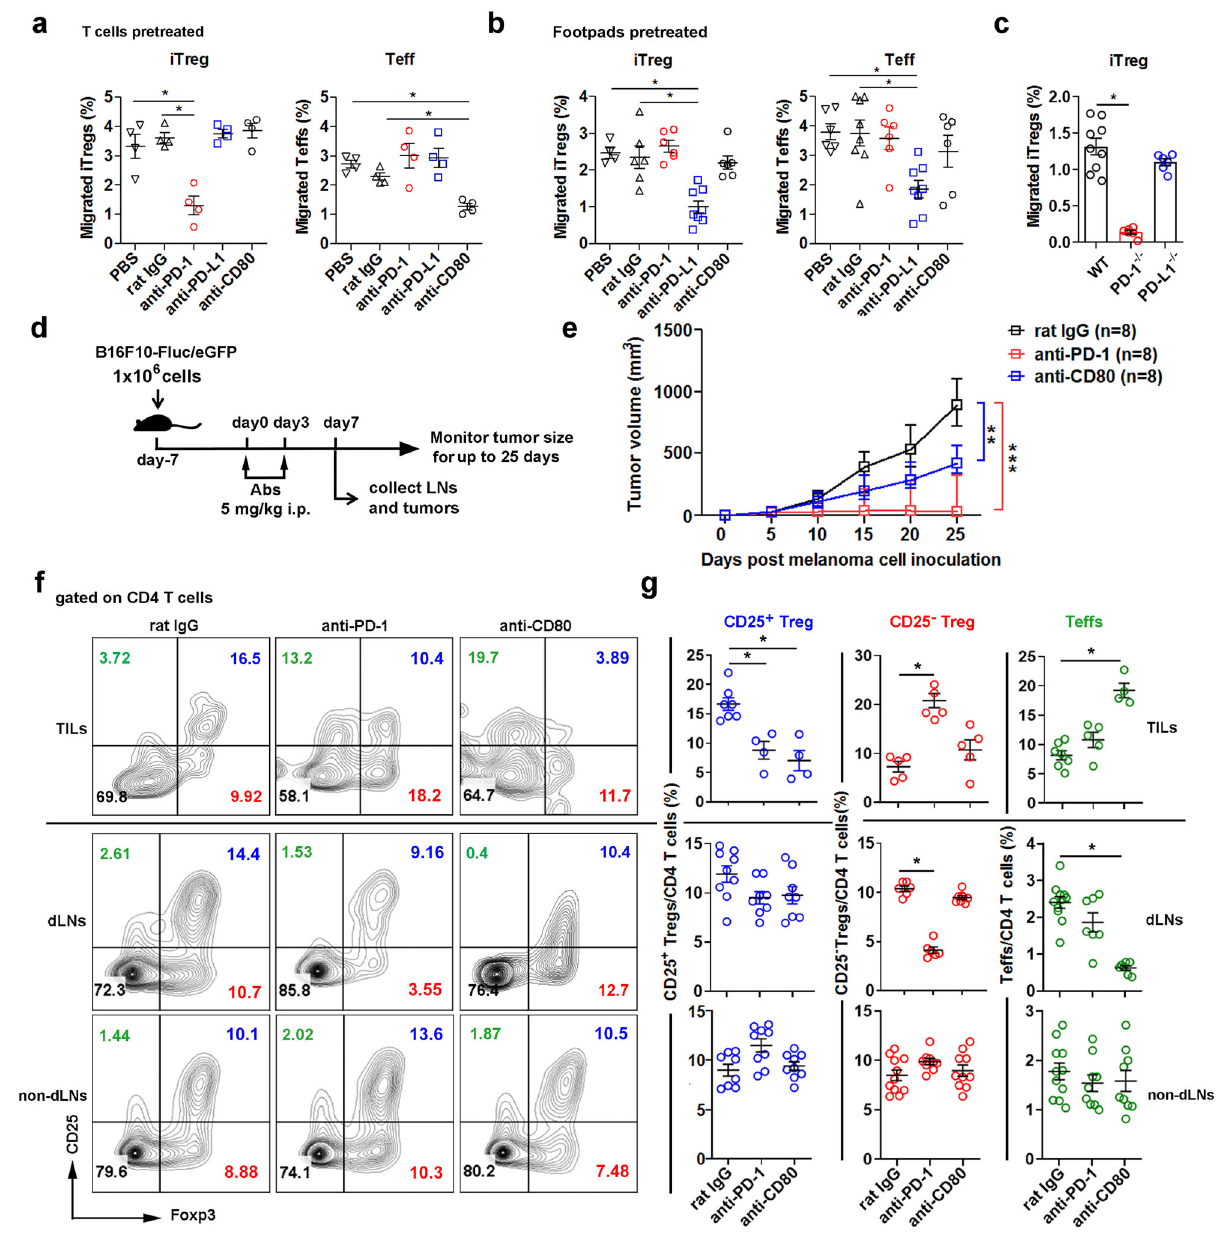
Fig. 6 PD-1 and CD80 blockade result in CD25-Treg and Teff accumulation in TILs, reduction in dLNs, and tumor regression. a – c In vivo footpad migration assays. a mAb-treated iTregs (left panel) or Teffs (right panel). b mAb pretreated footpads receiving iTregs (left) or Teffs (right). c untreated footpads receiving WT and PD-1 − / − iTregs. 1 × 10 6 cells transferred, and the migrated cells (CFSE + ) enumerated as the percentage of total CD4 T cells in popliteal dLNs. d – g B16F10-Fluc/eGFP tumor-bearing C57BL/6 mice treated with 5 mg/kg mouse weight of anti-PD-1 (Rmp1-14), anti-CD80 (1G10), or isotype rat IgG (2A3). Scheme of tumor treatment ( d ). Tumor growth curve ( e ). 8 mice/group; * p < 0.05, Two-way ANOVA, Holms- Š idák correction for multiple comparisons. Representative dot plots ( f ) and frequencies ( g ) of Foxp3 + CD25 + CD4Tregs, Foxp3 + CD25 − CD4 Tregs, and Foxp3 − CD25 + CD4 Teffs in total CD4 T cells of tumor-in fi ltrating lymphocytes (TILs) and of draining LNs (dLNs) or non-draining control LNs (non-dLNs) analyzed by fl ow cytometry. f , g Three to four mice/group. Data representative of 3 ( a – c , f , g ) and 2 ( e ) independent experiments. Mean ± SEM. * P < 0.05 by one-way ANOVA. Source data are provided as a Source Data fi